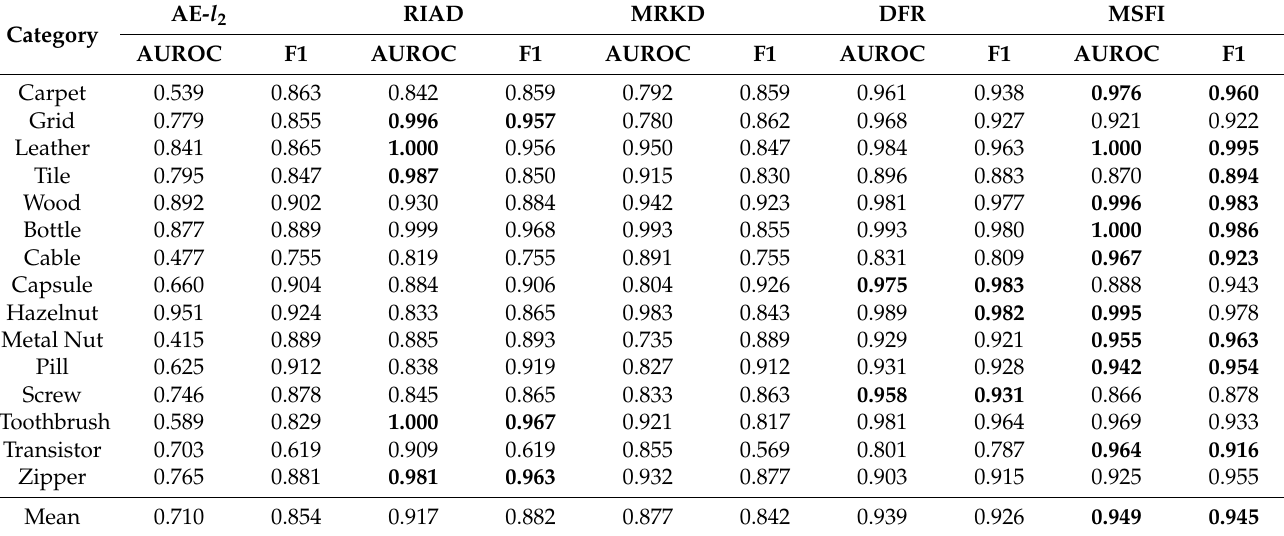
Table 1. The anomaly detection results on MVTec AD dataset. The best result for each class is